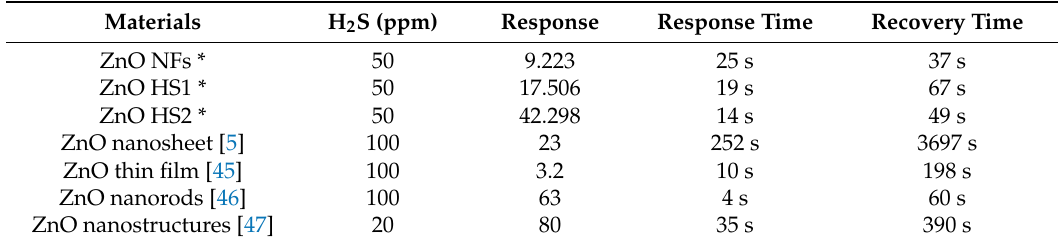
Table 1. Comparison of sensing characteristics of di ff erent ZnO nanostructures gas sensors. Materials H 2 S (ppm) Response Response Time Recovery Time ZnO NFs * 50